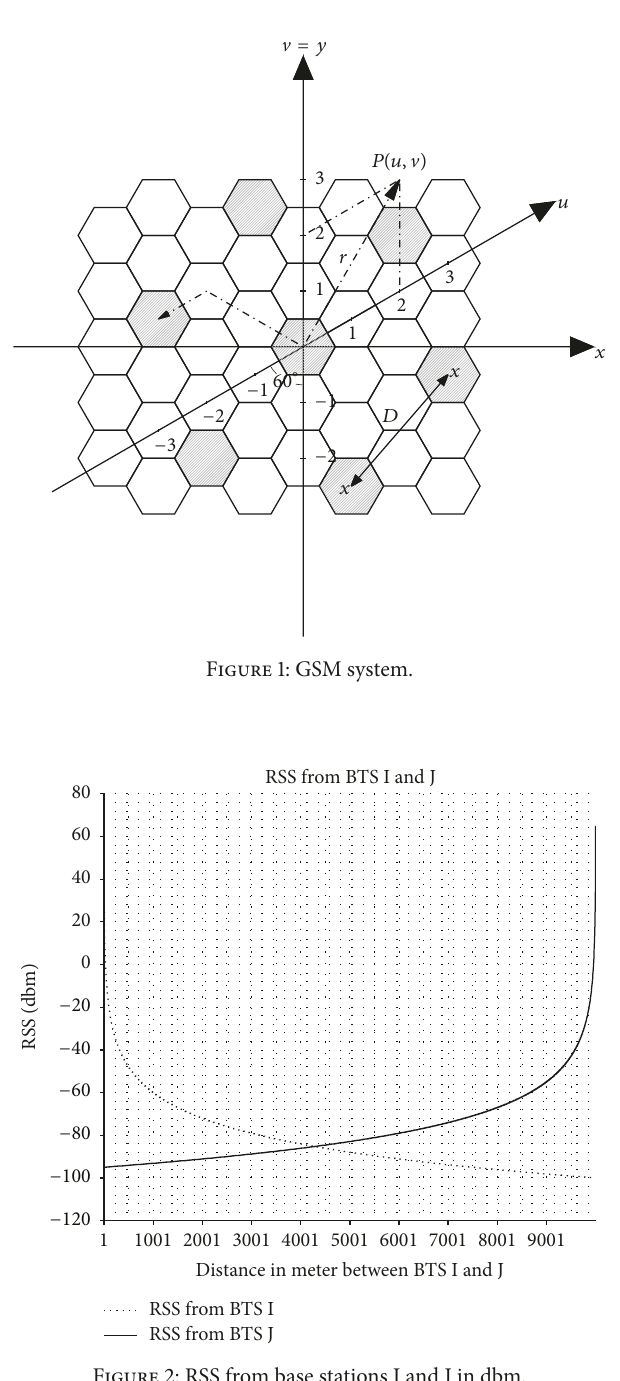
Figure 2: RSS from base stations I and J in